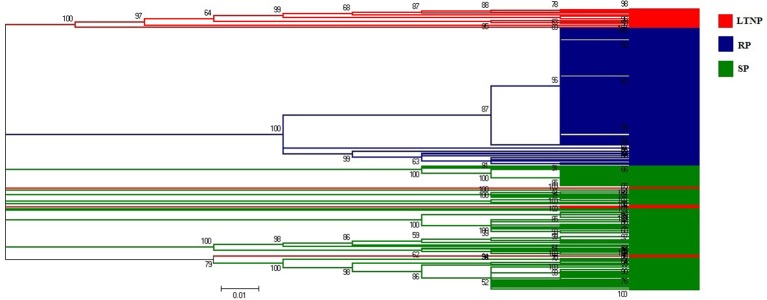
Neighbor-joining method based phylogenetic tree of the env genes (LTNP, SP, and RP). Red colored lines represent Long term non-progressor (LTNP) sequences. Blue colored lines refer to the Rapid progressor (RP) sets. Green colored lines depict the Slow progressor (SP) sequences.